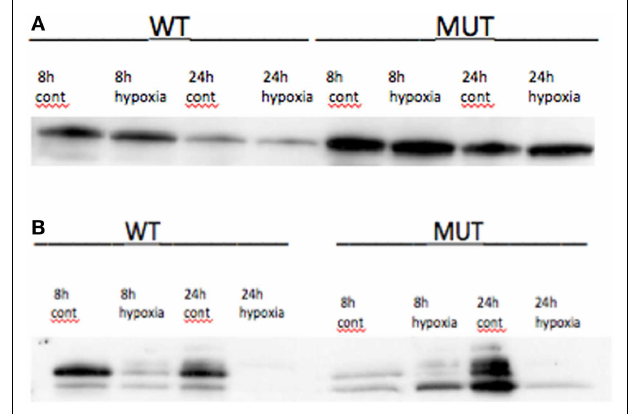
FIGURE 3 | (A) p53 protein expression under hypoxic conditions and control in TP53 wild-type and mutant A2780 cell lines. No changes in protein expression seen at 8 or 24h. (B) Effects of hypoxia on p21 expression in A2780 cell line. In wtA2780 cell line, no induction of p21 expression was seen under hypoxic conditions. In mA2780 cell line, hypoxia induced a small increase in p21 expression at 8h but was not present at 24h.